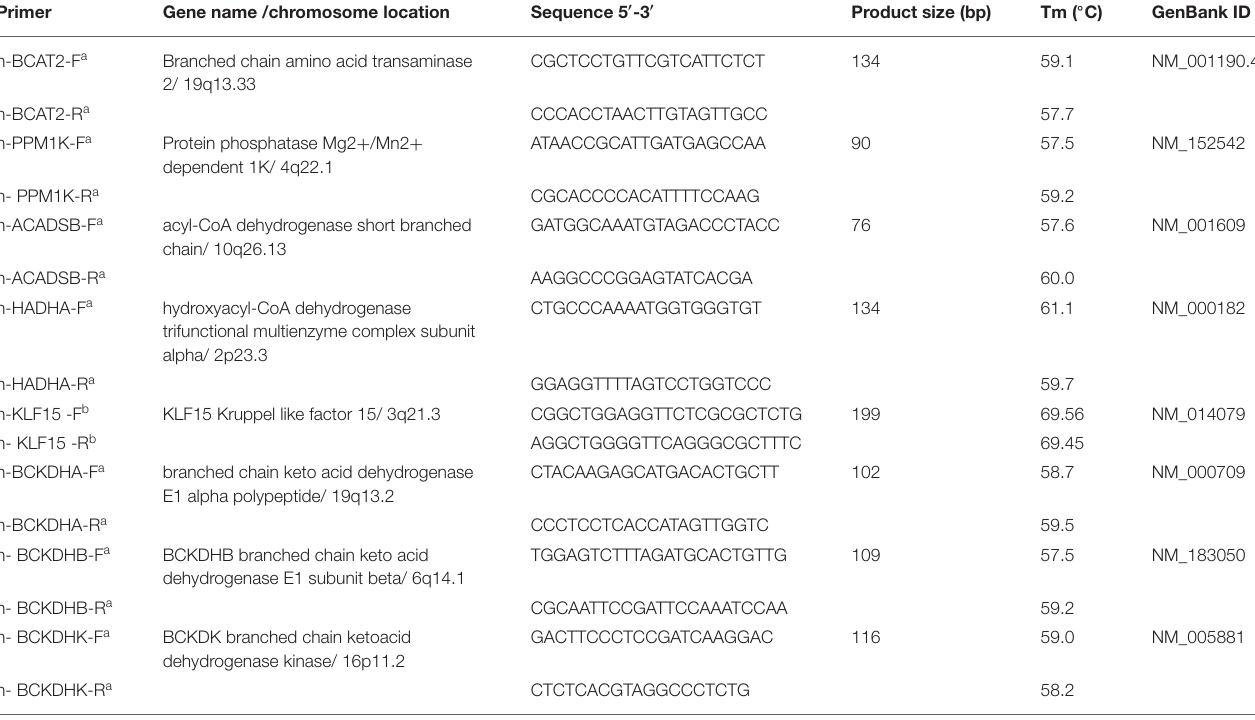
TABLE 8 | Details of specific primers and targets used in real-time qPCR